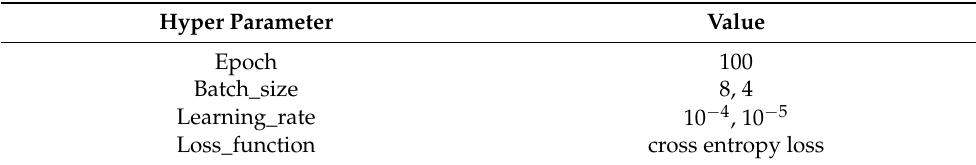
Table 3. PSPnet training hyper parameters and the